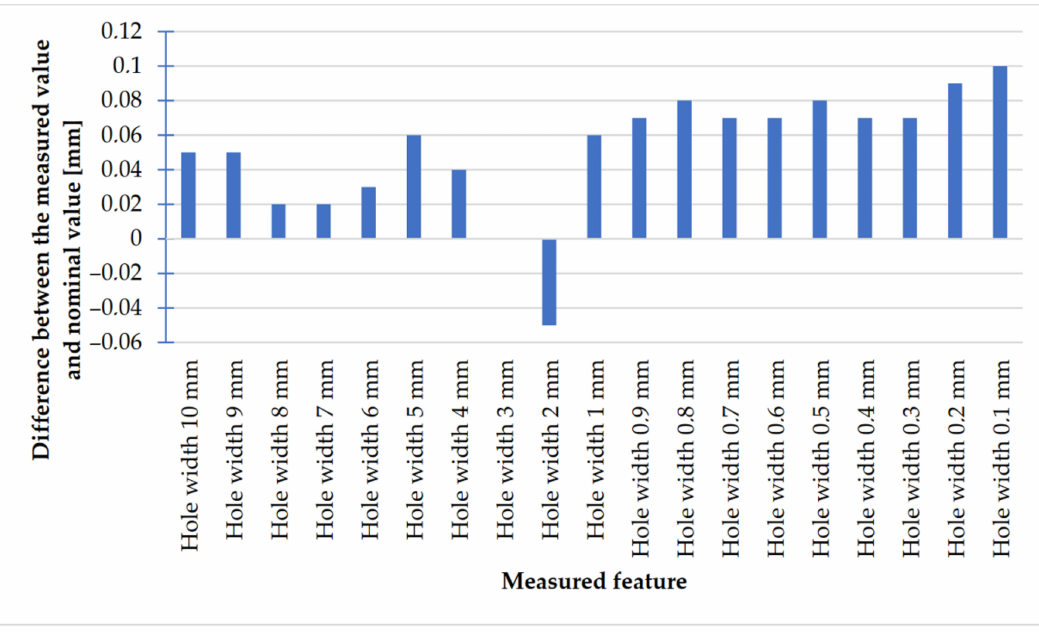
Figure 29. Deviation analysis for rectangular holes model made in the DMLS